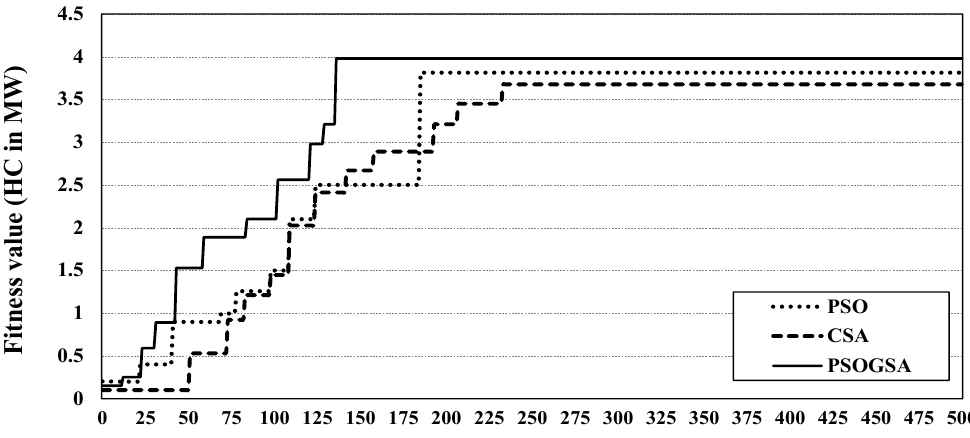
Figure 5. Convergence characteristics of PSOGSA, PSO, and CSA.